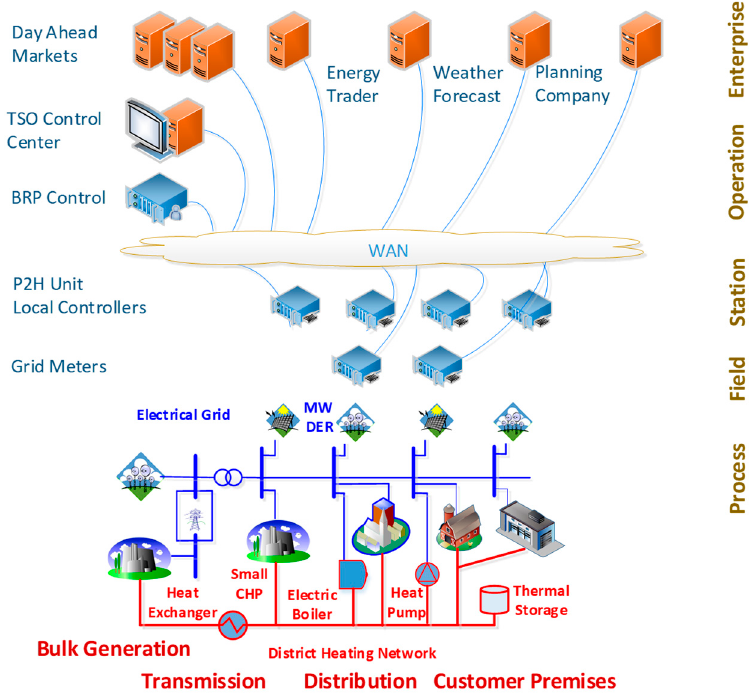
Figure 1. Mapping of Frequency Regulation Use Case in SGAM Framework.